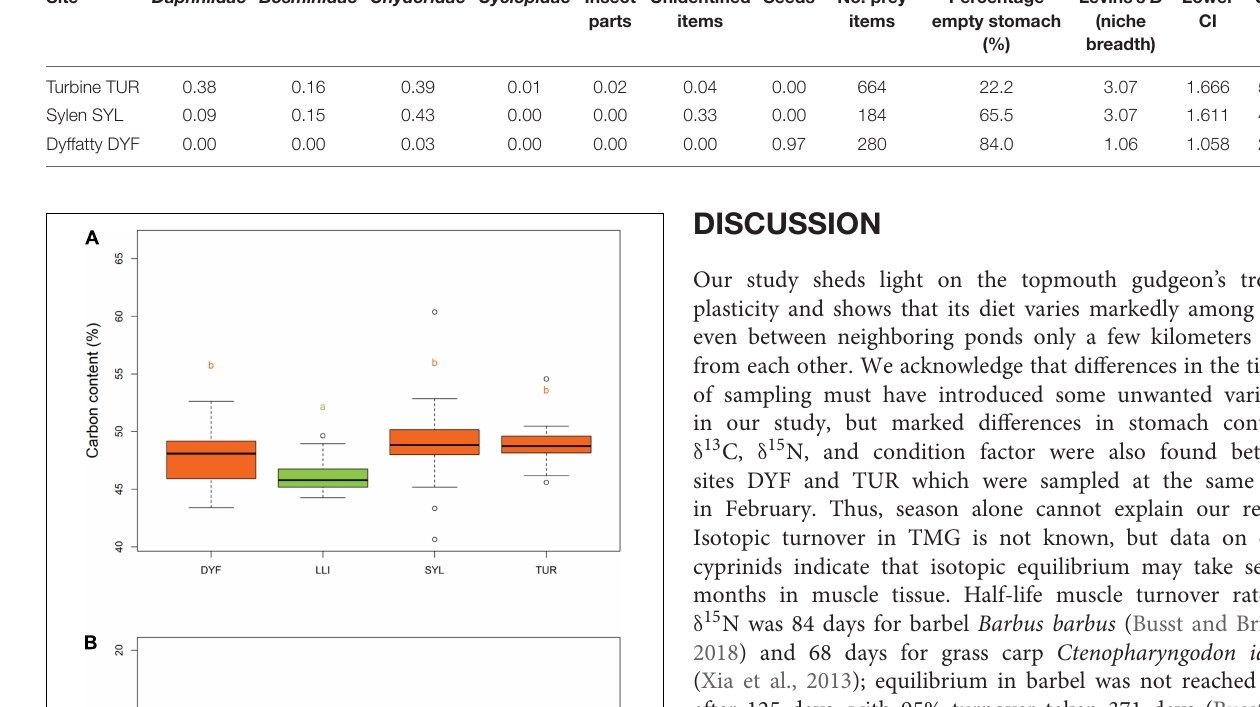
Unidentified Seeds No. prey Percentage parts items items empty stomach